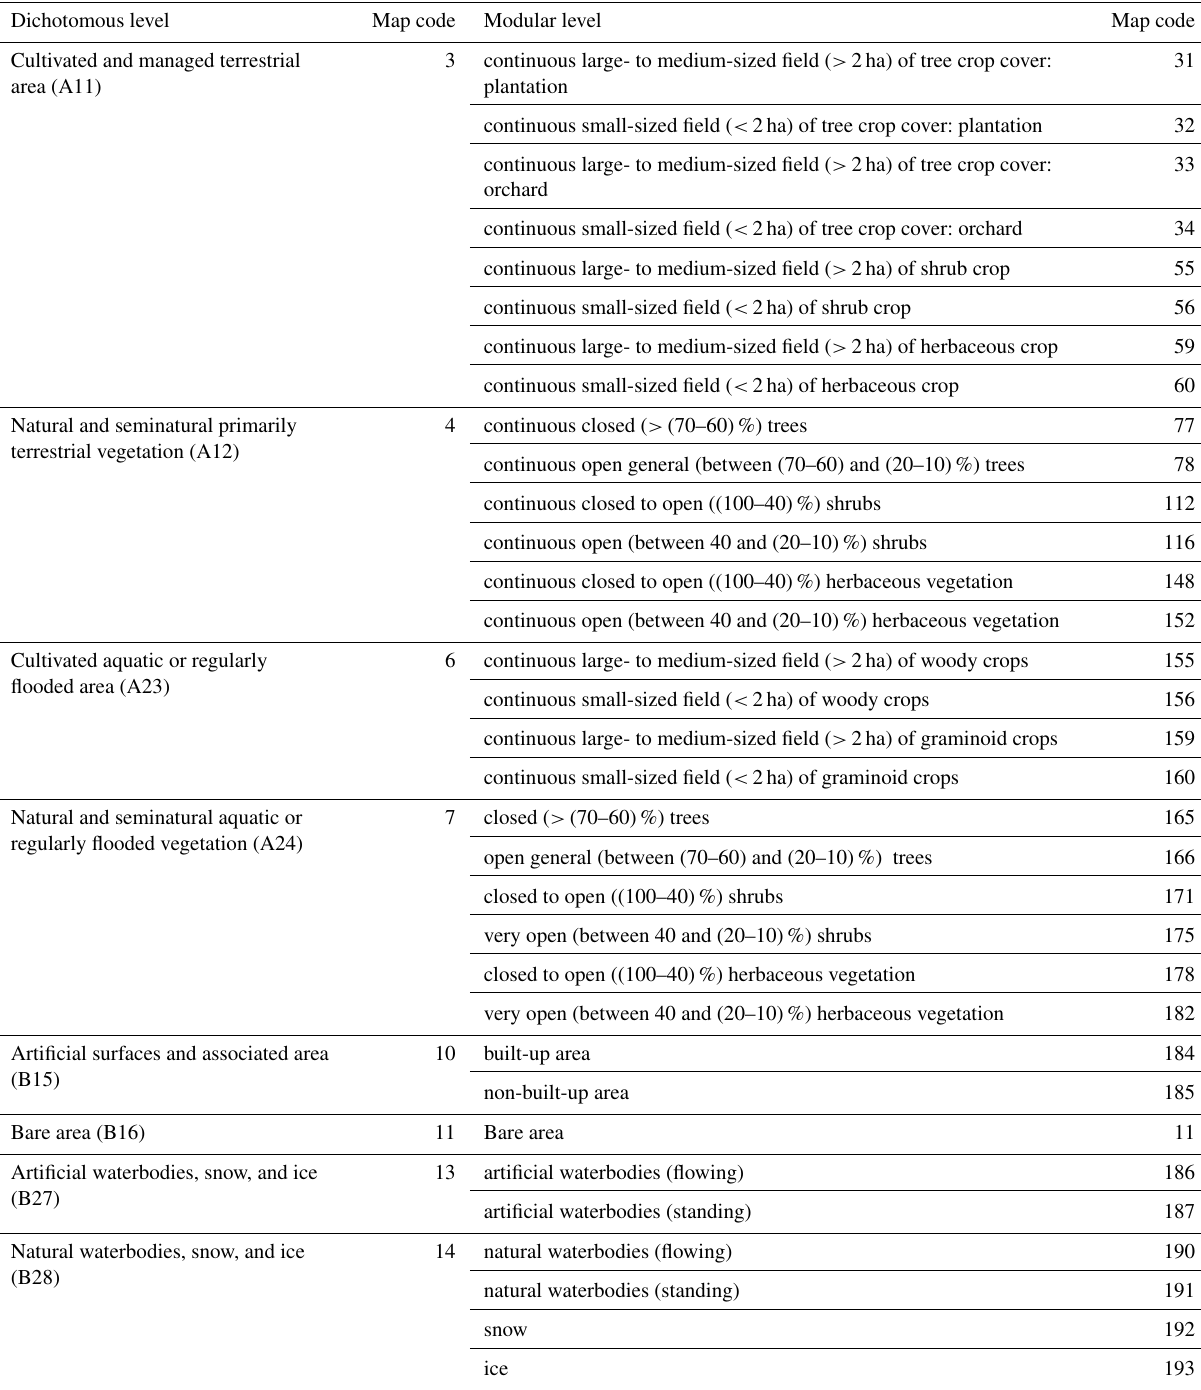
Table 2. Dichotomous and Modular thematic land cover and land use classes. Dichotomous